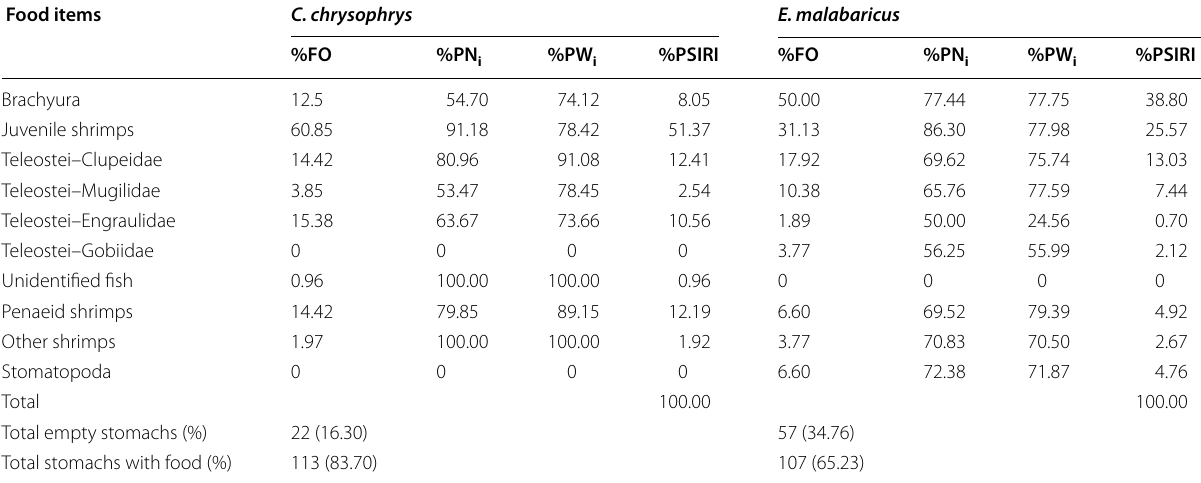
Table 1 Diet composition of Carangoides chrysophrys and Epinephelus malabaricus from the Pangani Estuary